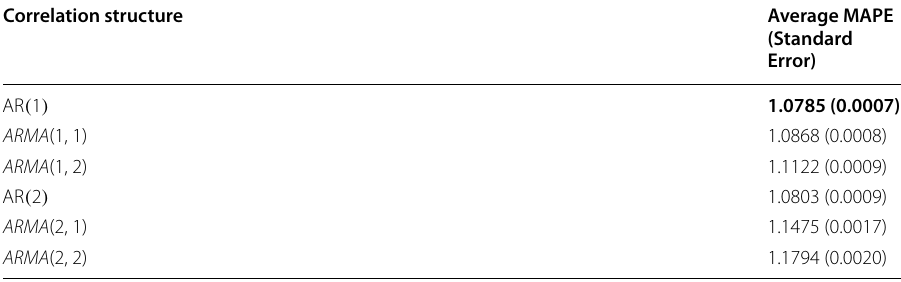
Bold value indicate the best models (Lower MAPE)